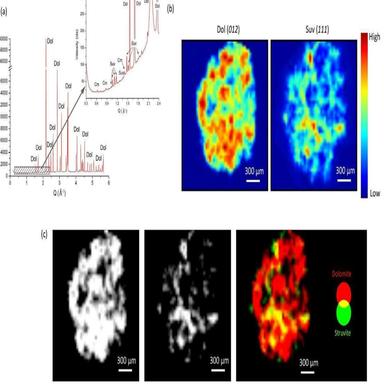
(a) Sum of XRD pattern of the DAP-treated Angera stone extracted from a representative slice of XRDCT datasets. The XRD pattern is dominated by Bragg peaks of dolomite (Dol). The inset, showing detail in the 0.3–2.4 A˚ −1 Q-range of the XRD pattern, highlights the presence of accessory clay minerals (Cm) of the original stone matrix and newly-formed struvite (Suv); (b) XRDCT reconstruction images obtained by integrating the XRD marker peaks in the Q-range 1.68–1.72 A˚ −1 (max at Q 1.70 A˚ −1 (d012) and 1.45